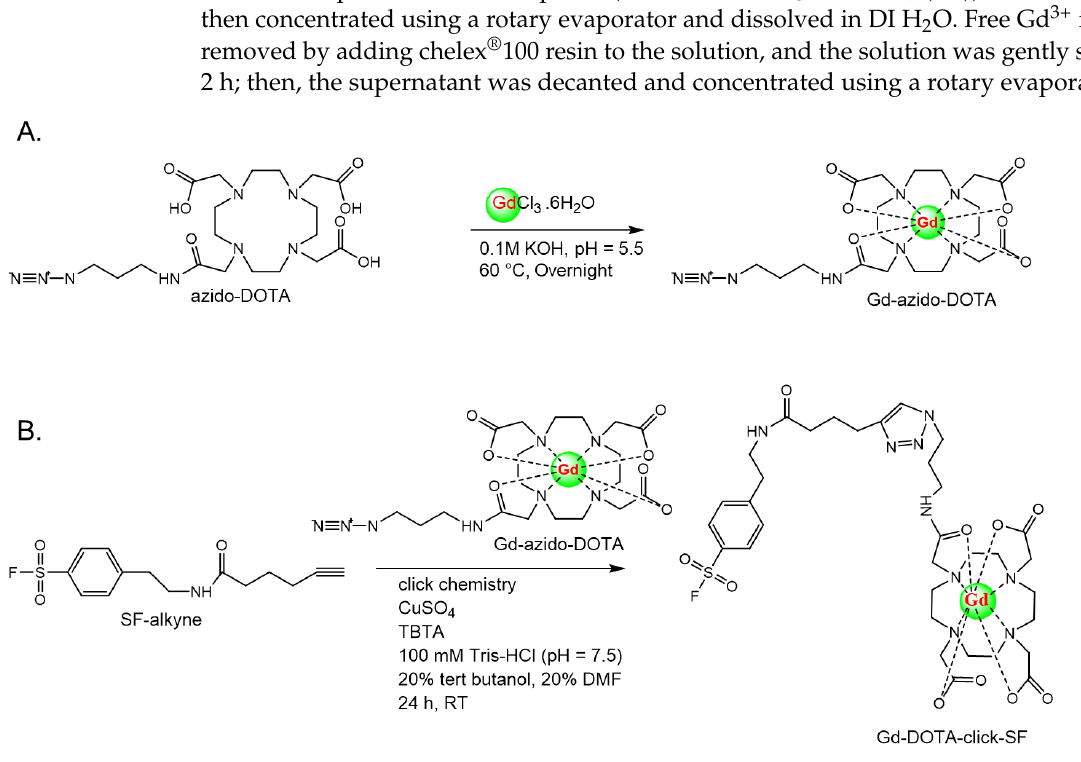
Scheme 2. Schematic illustration of the synthesis procedure of Gd-azido-DOTA complex ( A ) and Gd-DOTA-click-SF probe ( B